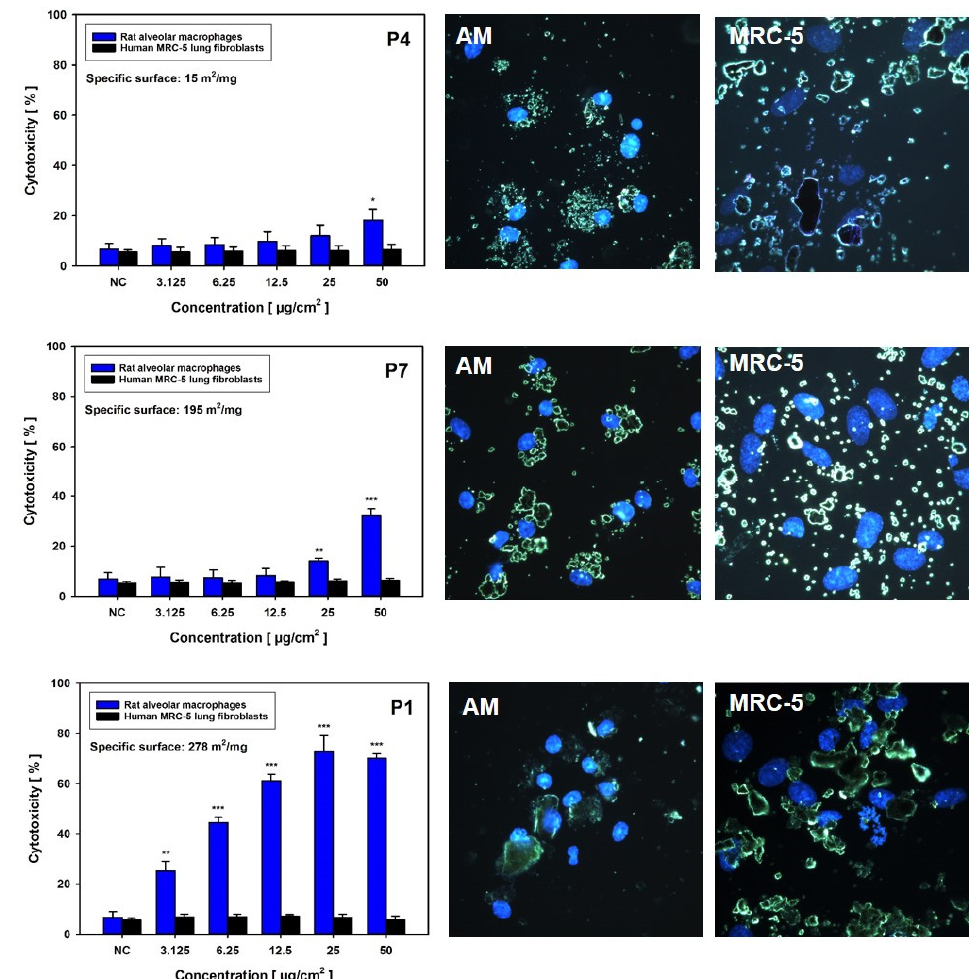
Figure 5. Material-dependent induction of membrane damage and cellular uptake in rat alveolar macrophages (AM; blue bars) and human MRC-5 lung fibroblasts (black bars). Cells were incubated without (NC) or with the given concentrations of P4, P7 or P1 for 24 h, with subsequent measurement of LDH activity in culture supernatants. Data represent arithmetic means ± SD of three independent experiments. */**/*** Statistically significant difference from NC: p ≤ 0.05, p ≤ 0.01 and p ≤ 0.001, respectively. On the right-hand side, fluorescence-coupled darkfield microscopy pictures are given for both cell types. Cells were incubated for 24 h with P4, P7 or P1 at 6.25 µg/cm 2 . Cell nuclei were subsequently stained with DAPI.